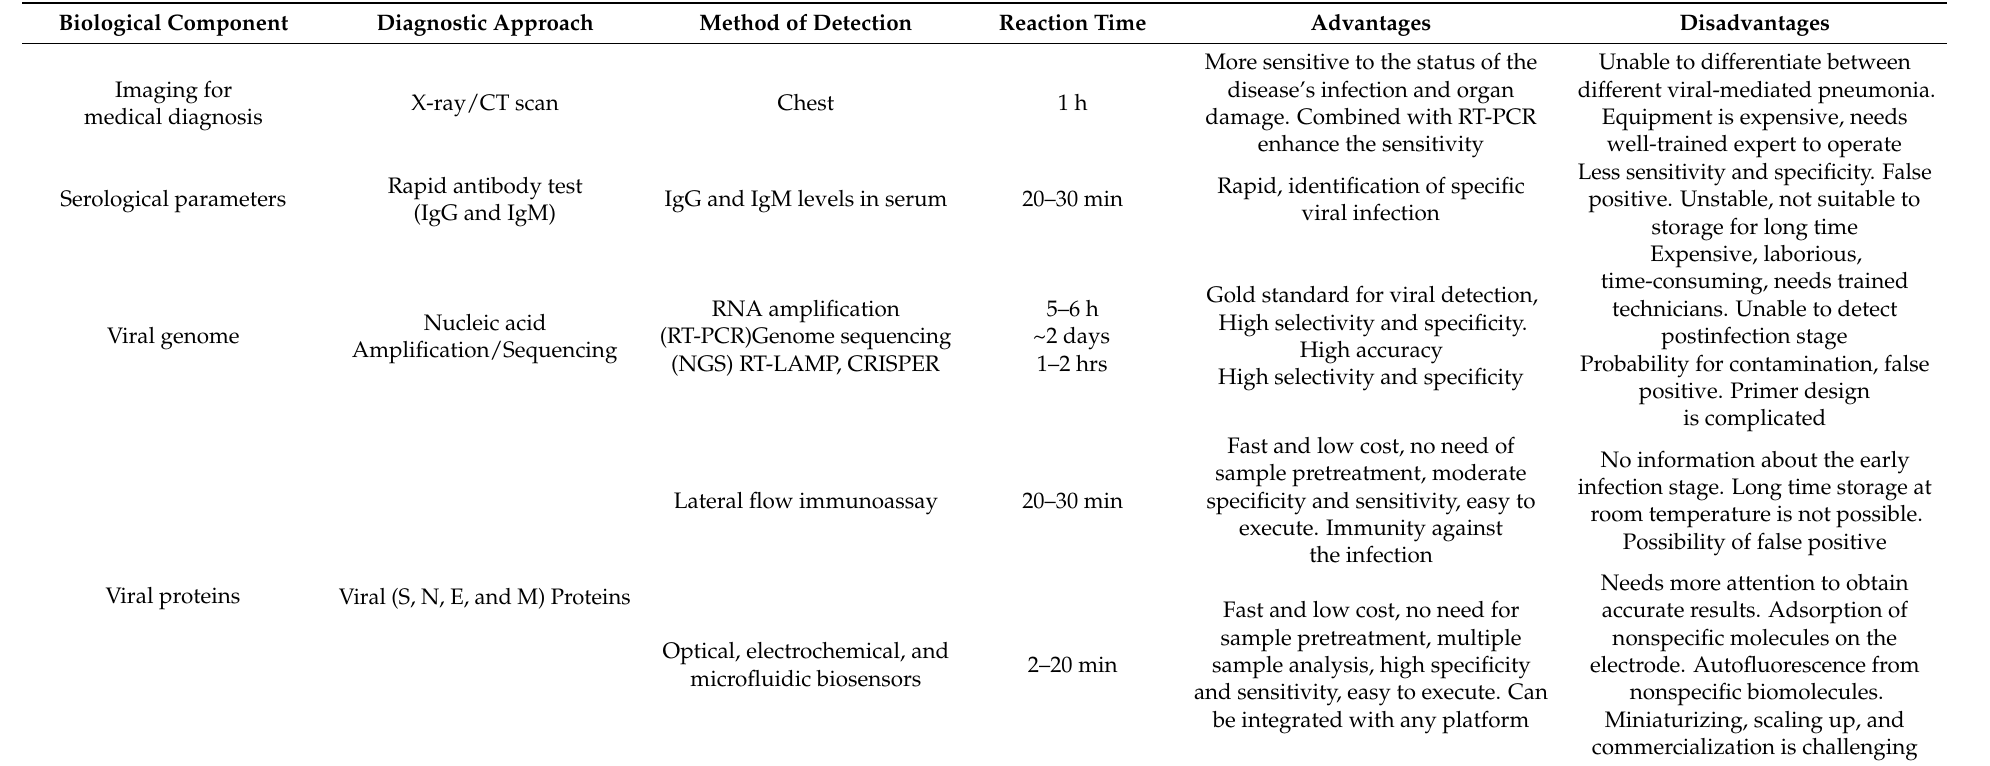
Table 2. Diagnostic approaches to detect